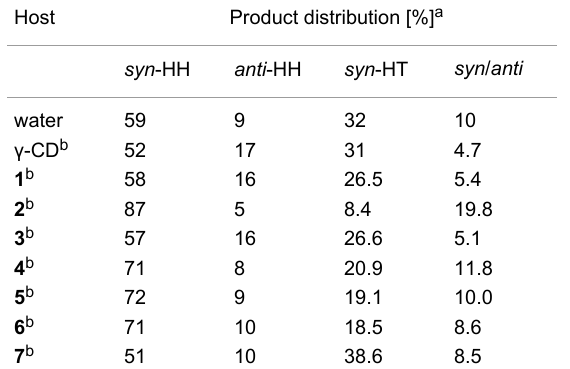
Table 3: Distribution of the photodimers of COU for various media.